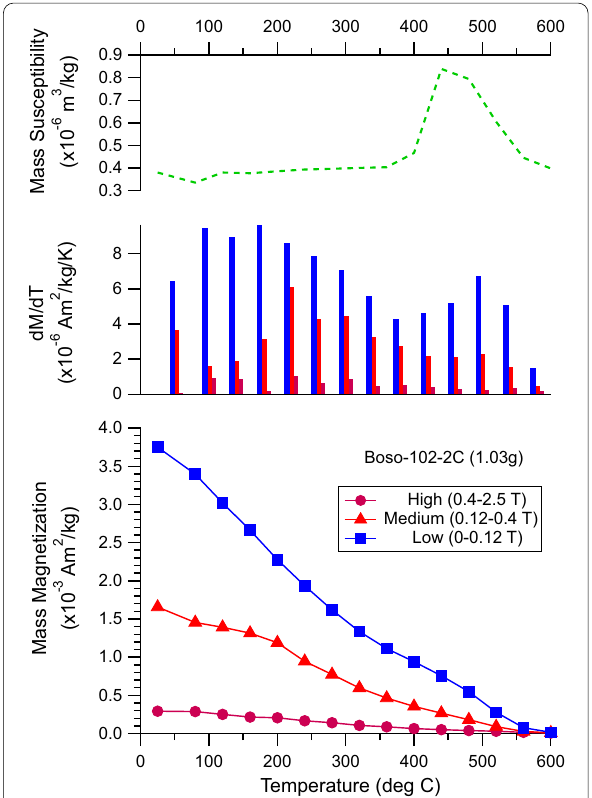
Fig. 6 An example of thermal demagnetization of three-component IRM experiments based on Lowrie (1990). Bottom diagram shows the magnetization for high (red circles; 0.4–2.5 T), medium (pink triangles; 0.12–0.4 T) and low (blue rectangles; 0–0.12 T) coercivity components after each heating step in air. Middle diagram shows the magnetization removed at each heating step for high (red), medium (pink) and low (blue) coercivity components. Top diagram shows the magnetic susceptibility measured after each heating